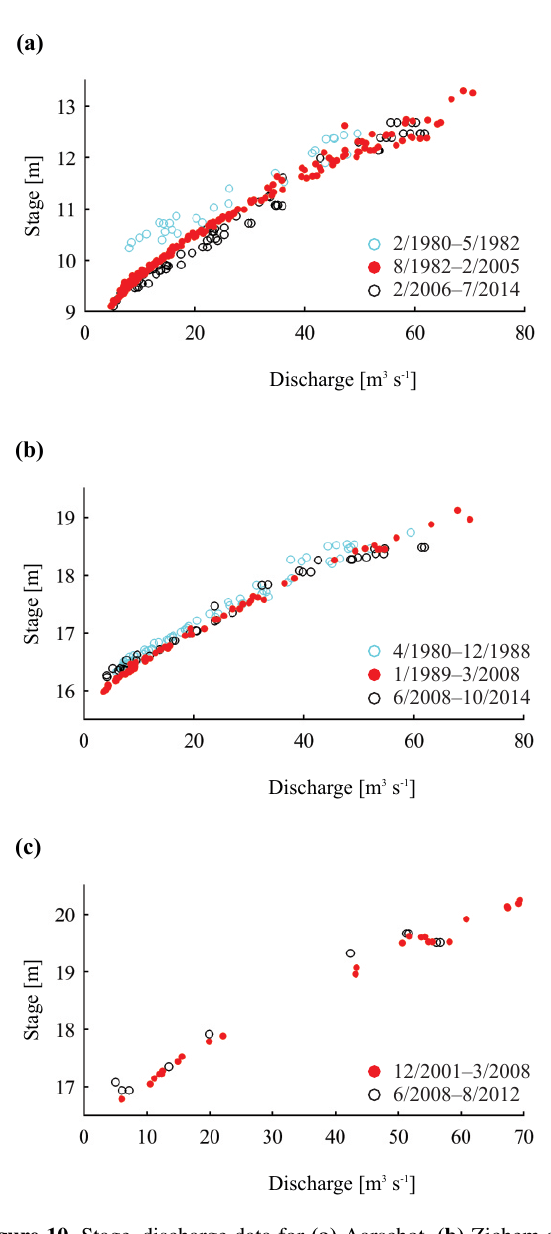
Figure 10. Stage–discharge data for (a) Aarschot, (b) Zichem and (c)